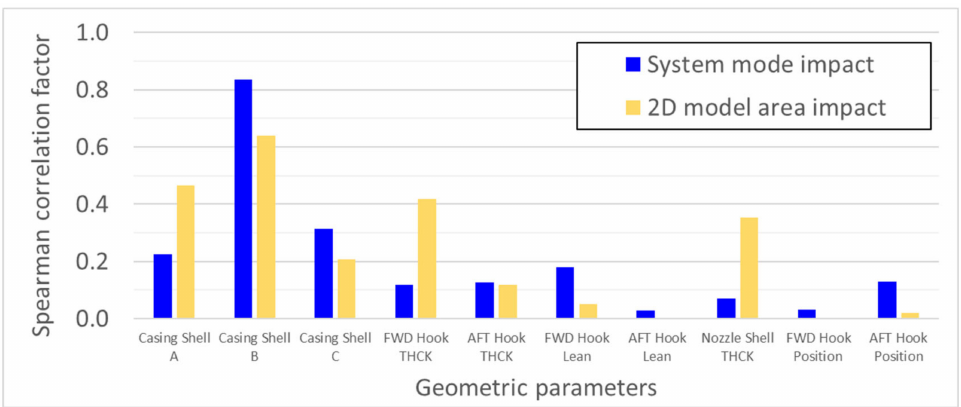
Figure 15. Spearman correlation factor for analyzed responses.